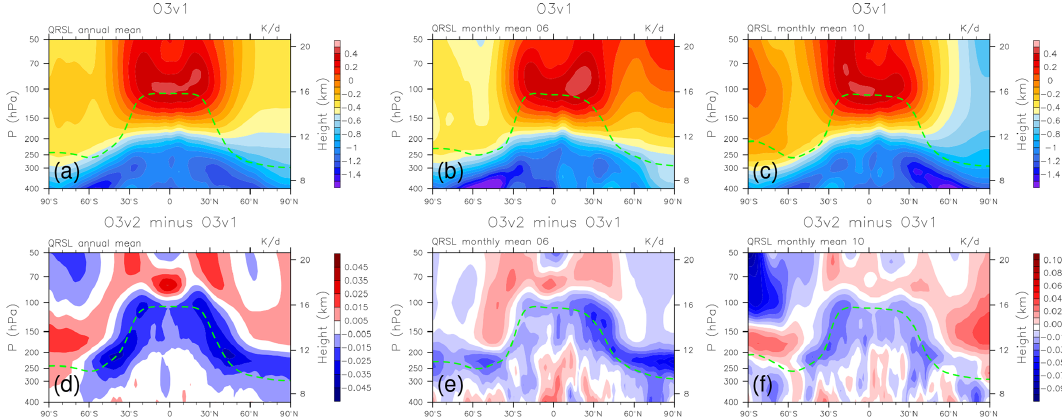
Figure 8. The same as Fig. 7 but for total net heating.